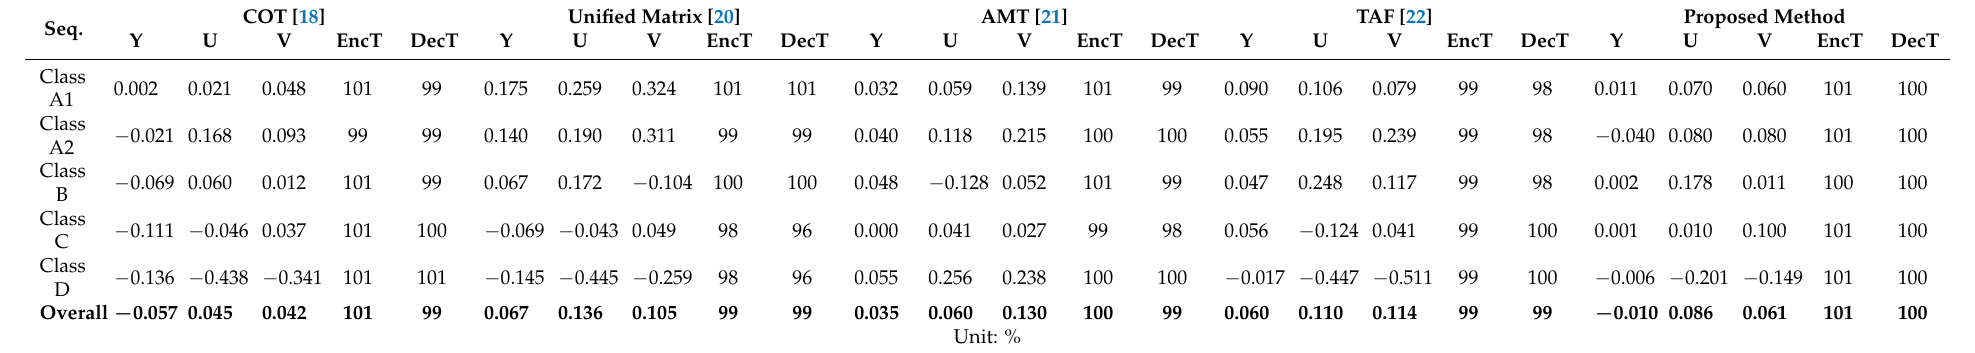
Table 4. Comparison of the overall simulation results for the derivation of transform kernels with the proposed method